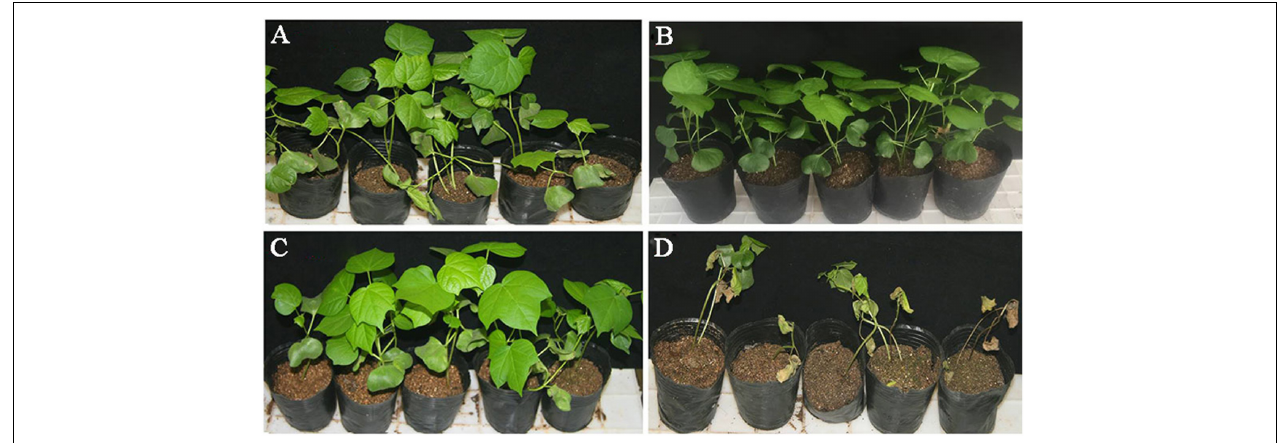
FIGURE 1 | Efficacy of F. proliferatum 10R-7 in suppression of Verticillium wilt of cotton caused by Verticillium dahliae (25 ± 3 ◦ C, 30 days postinoculation) in a greenhouse experiment. (A) Cotton seedlings treated with sterile water control (CK). (B) Cotton seedlings treated with F. proliferatum 10R-7 alone (10R-7 alone). (C) Cotton seedlings treated with F. proliferatum 10R-7 plus V. dahliae (10R-7 + Vd ). (D) Cotton seedlings treated with V. dahliae alone ( Vd alone). TABLE 4 | Inhibition of mycelial growth of Verticillium dahliae by the culture filtrates and the volatiles produced by the F. proliferatum 10R-7. Isolate Culture filtrates Volatiles Colony diameter (cm) Inhibition percentage Colony diameter (cm) Inhibition percentage F. proliferatum 10R-7